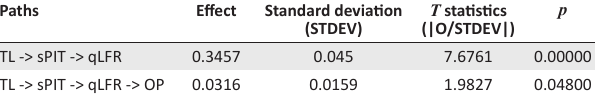
TABLE 4: Specific indirect